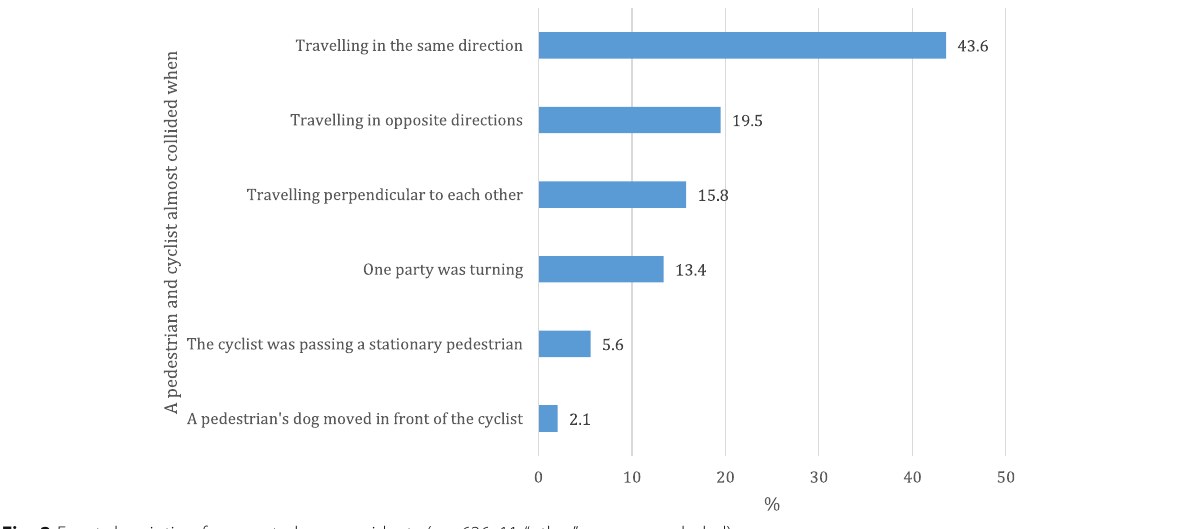
Fig. 2 Event description for reported near accidents ( n = 626. 11 “ other ” answers